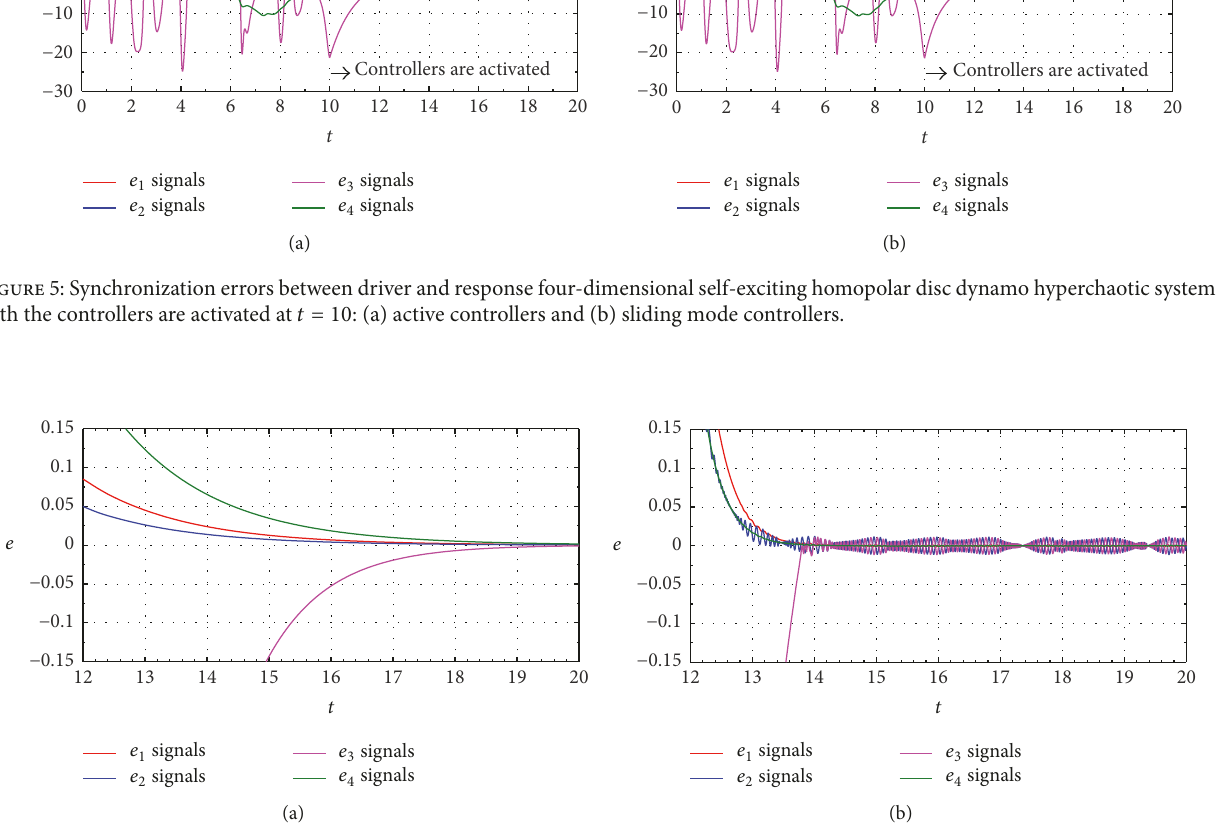
Controllers are activated